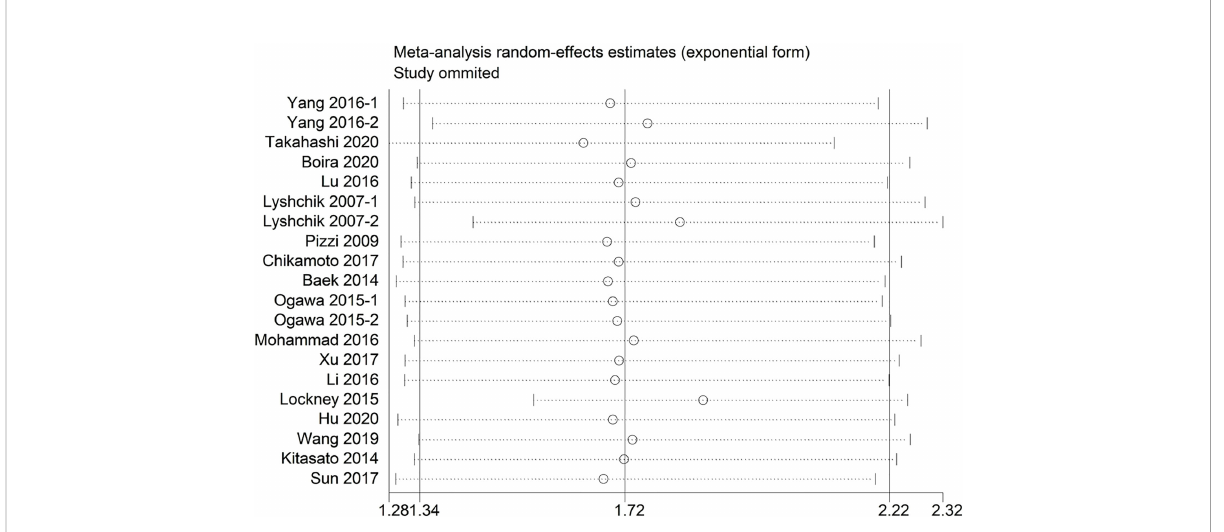
FIGURE 2 Sensitivity analysis between the expression levels of glycolysis markers and overall